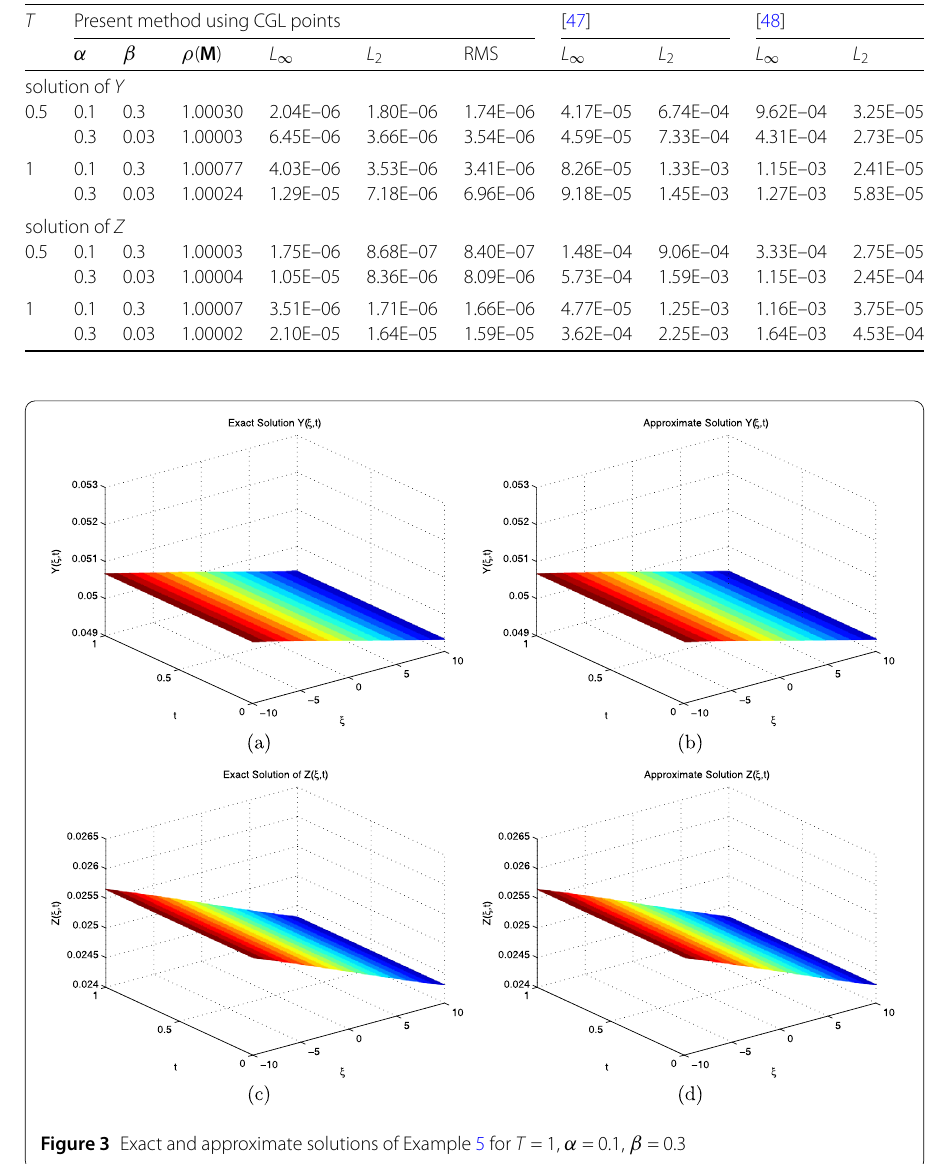
Figure 3 Exact and approximate solutions of Example 5 for T = 1, α = 0.1, β =